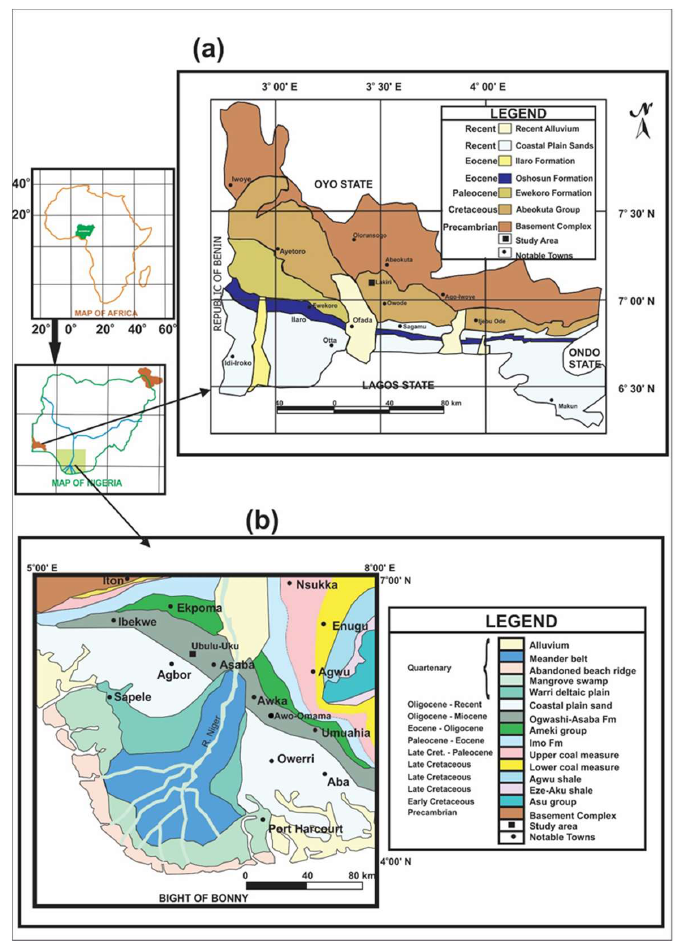
Figure 2. Geologic Maps of ( a ) Eastern Dahomey and ( b ) Niger Delta Basins showing the study areas (Modified after [30,40]).